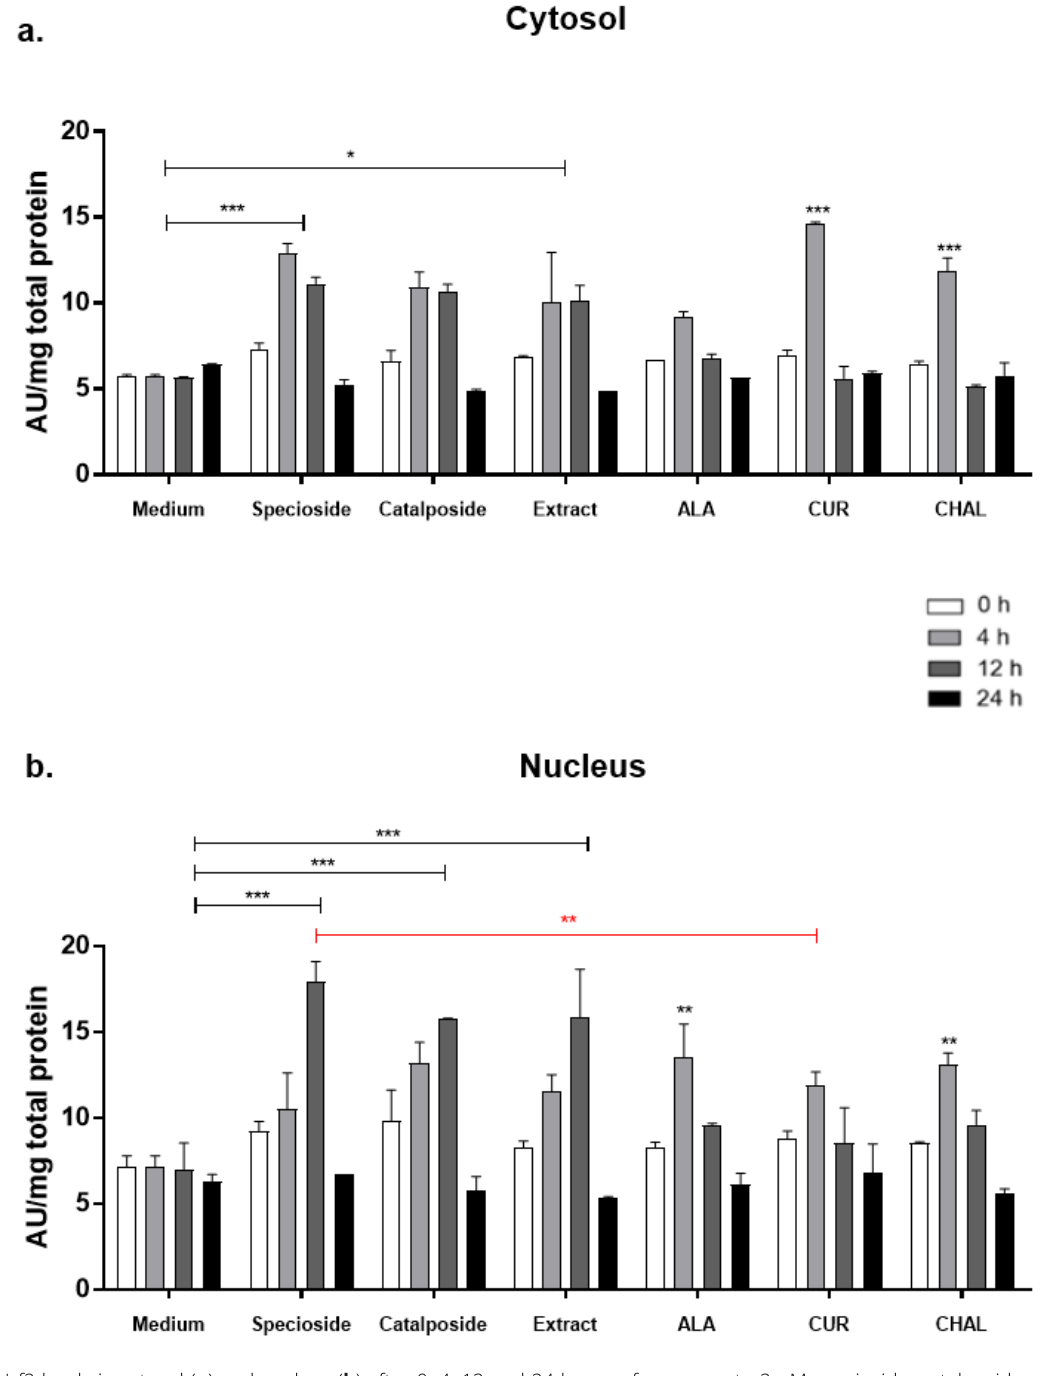
Figure 3. Nrf2 levels in cytosol ( a ) and nucleus ( b ) after 0, 4, 12 and 24 hours of exposure to 2 µM specioside, catalposide, controls and 1 µg/mL n -butanol extract. Kruskal Wallis, Dunn’s post hoc. * p<0.05, ** p<0.01, *** p<0.001. ALA, α-lipoic acid; CUR, curcumin; CHAL,